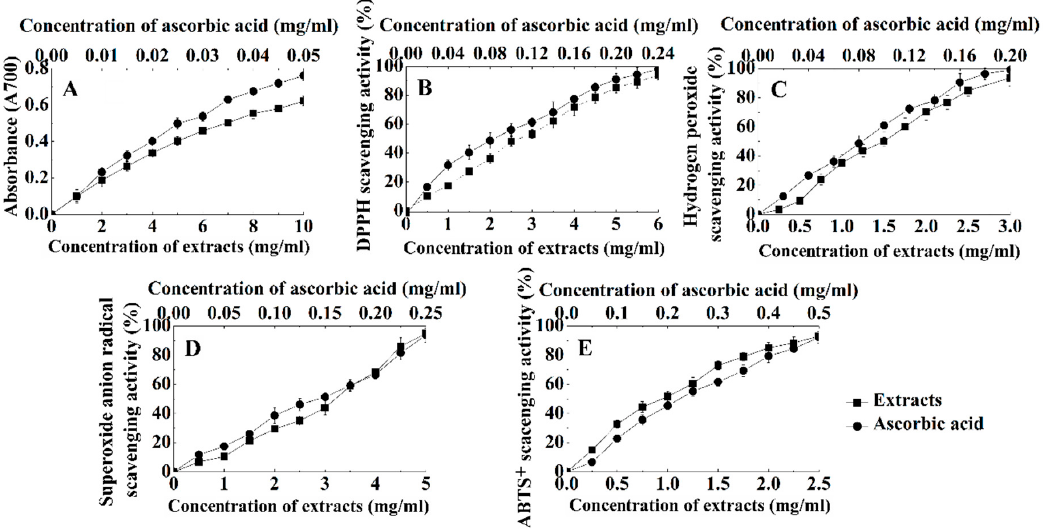
Figure 5. Antioxidant activity of the extracts from P. notoginseng stem leaf and ascorbic acid at different concentrations. ( A – E ) were the ferric ions reducing activity, the DPPH radical scavenging rate, the hydroxyl radical scavenging rate, the superoxide anion scavenging rate and the ABTS + radical scavenging rate,